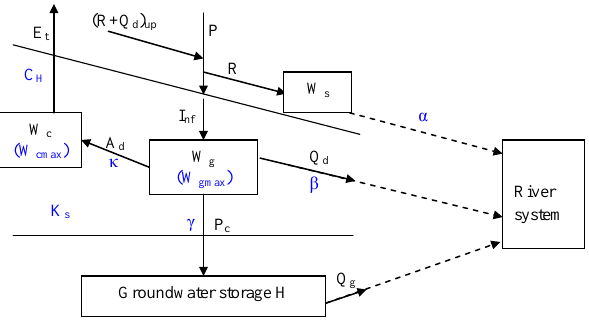
Figure 1. A schematic representation of MOBIDIC. Boxes denote different water storages (gravitational storage W g , capillary storage W c , groundwater storage H , surface storage W s , and the river sys- tem), solid arrows fluxes (evaporation E t , precipitation P , infiltra- tion I nf , adsorption A d , percolation P c , surface runoff R , interflow Q d , groundwater discharge Q g , and surface runoff and interflow from upper cells ( R + Q d ) up ) , dashed arrows different routings, and blue characters major model